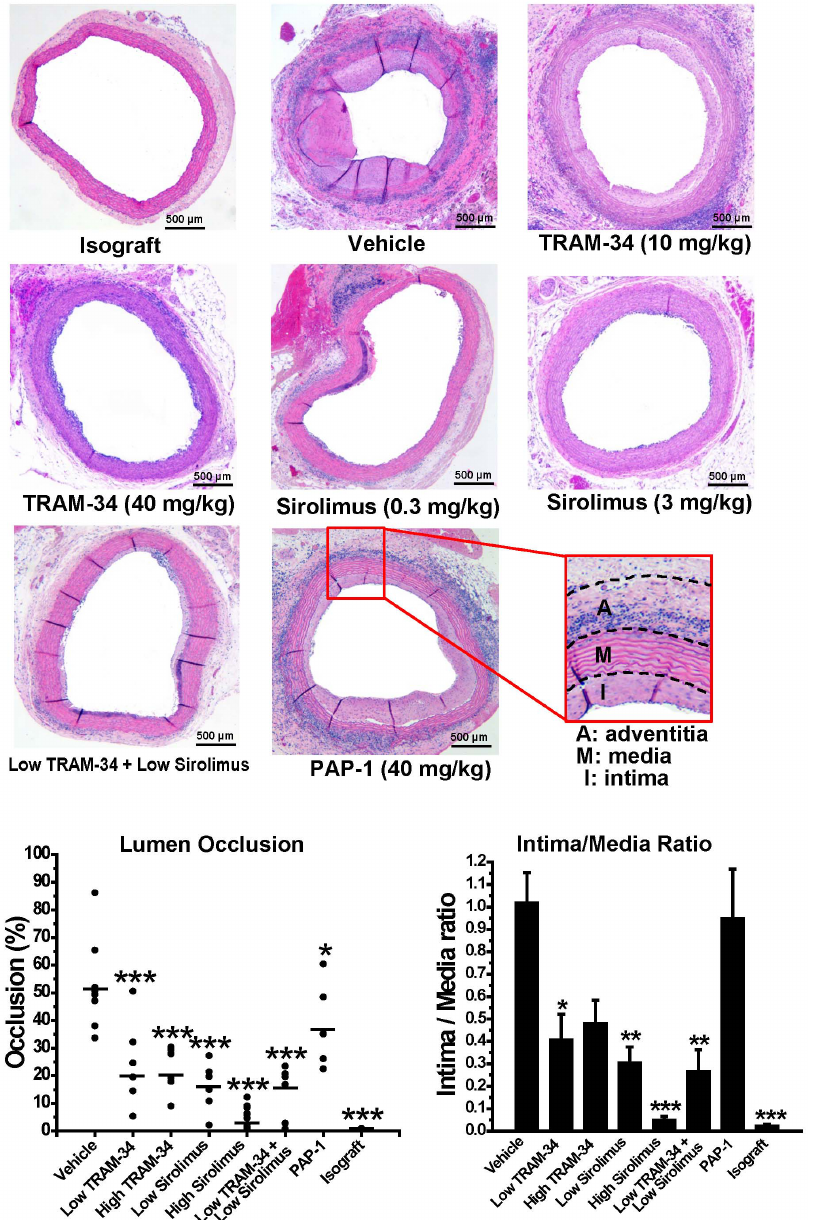
Figure 4. KCa3.1 blockade reduces luminal occlusion. (A) Representative images of H&E stained aortic grafts harvested 120 days after transplantation (50-fold magnification). (B) Percentage of luminal occlusion and intima/media ratios evaluated at three different levels of each harvested graft in the different treatment groups. For averaged values and statistics see Supporting Table 1 in File S1.